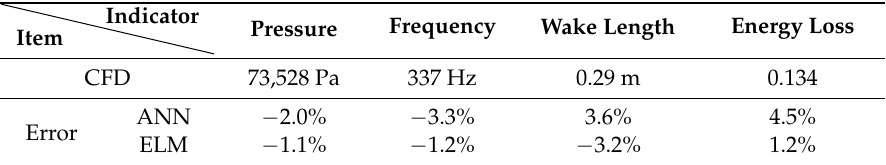
Table 2. Comparison between the results of ANN and ELM.